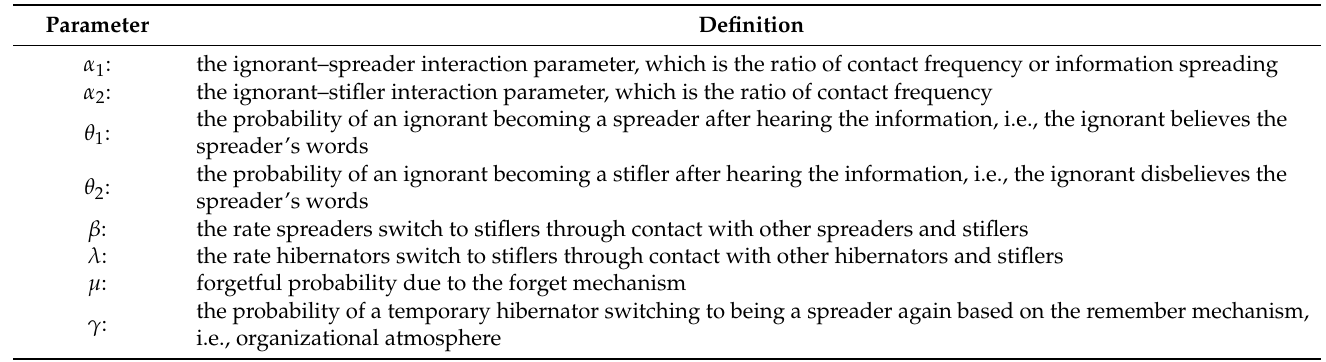
Table 2. Definitions for key parameters and dynamic